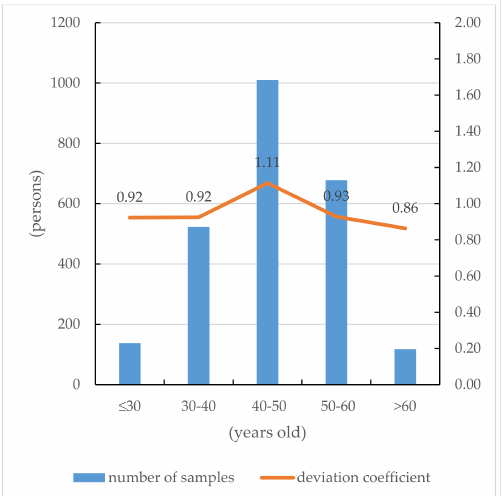
Figure 5. Deviation coefficient of agricultural machinery utilization rate grouped by age.